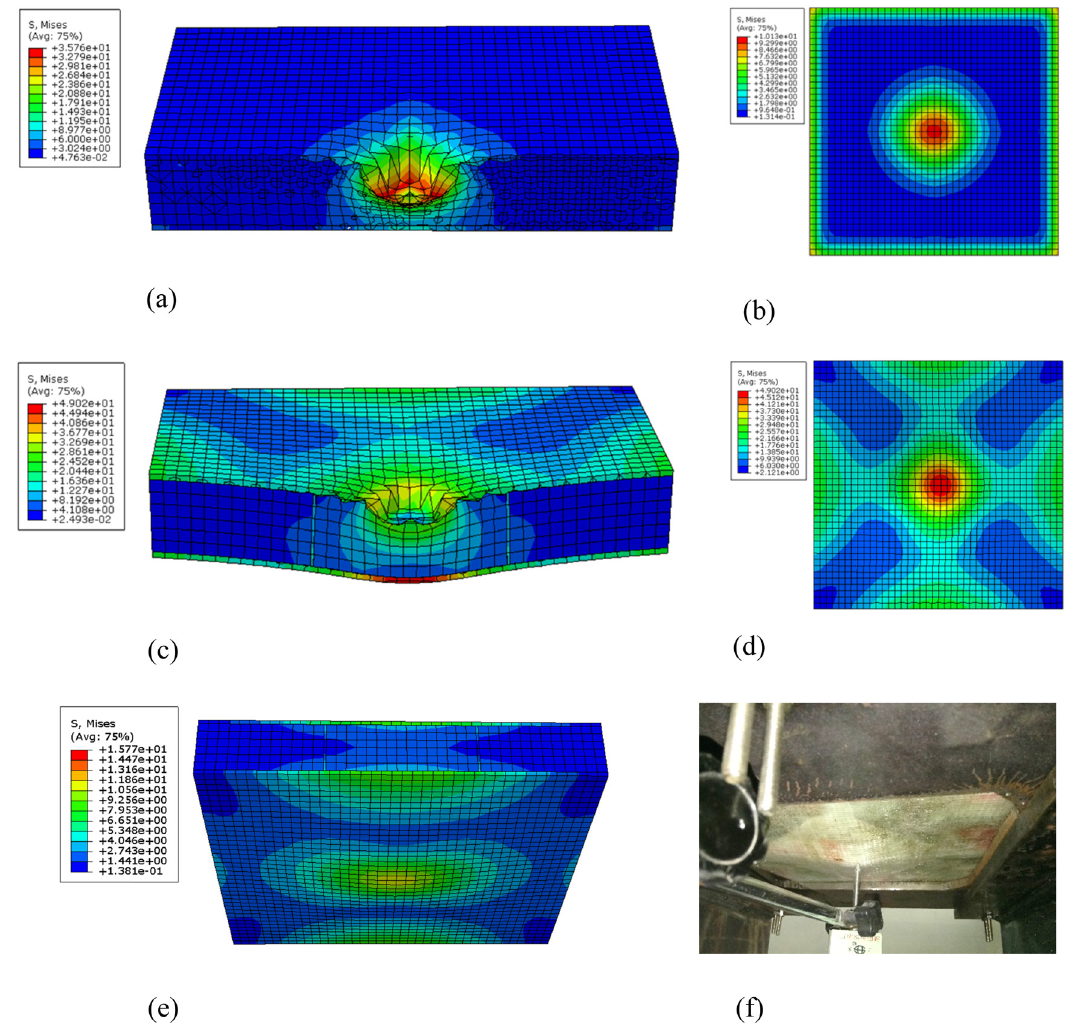
Figure 11: Stress contour at the peak load ( unit: MPa ) . ( a ) Cross section of F41D30. ( b ) Rear surface of F41D30. ( c ) Cross section of F41D30w2. ( d ) Rear surface of F41D30w2. ( e ) Numerical progress of F41D30w2. ( f ) Experimental progress of